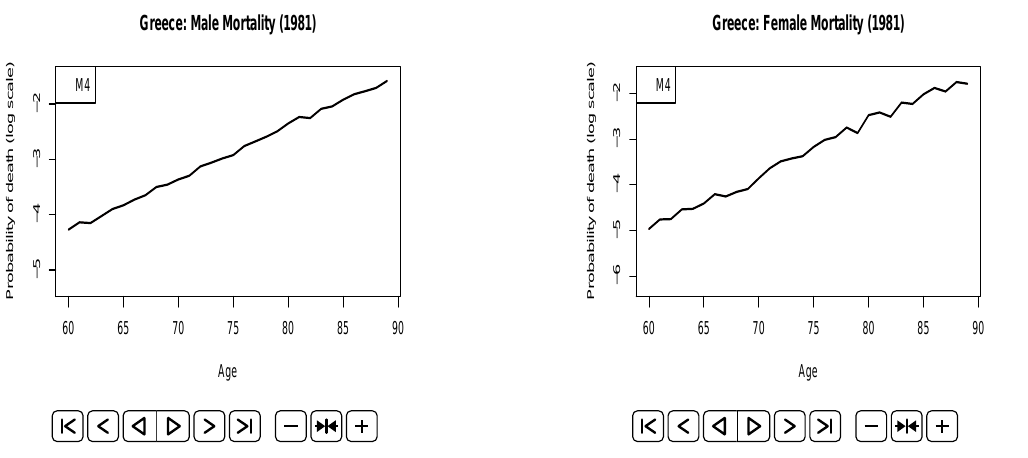
Figure A4. M 4 for males and females.